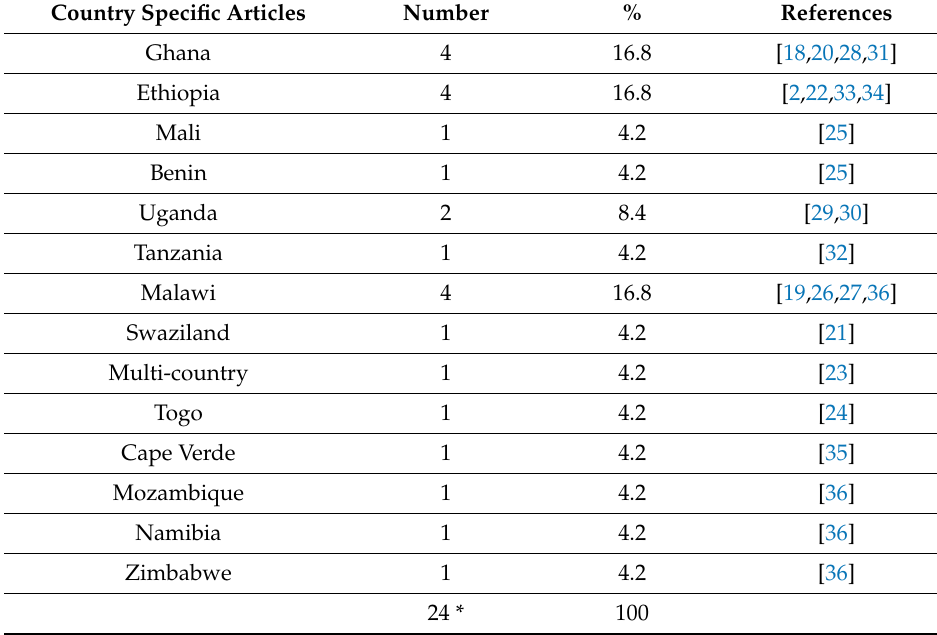
Table 2. Study profiles by